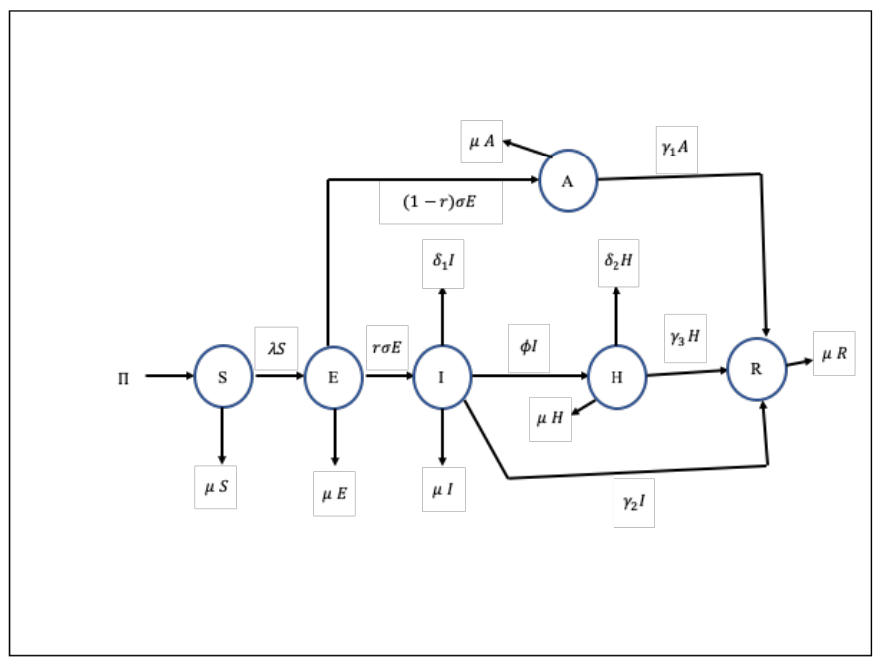
Figure 1. Model (1) schematic